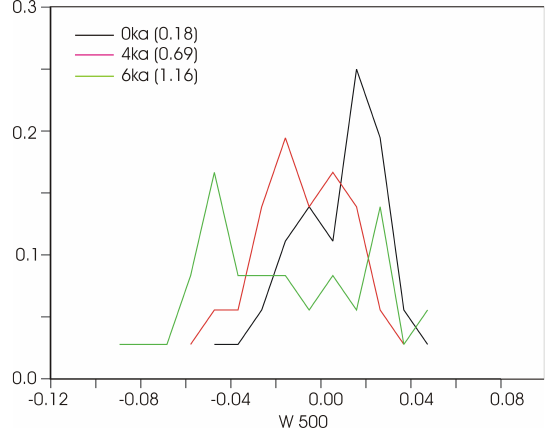
Fig. 6. Probability density function of 500hPa (w500, in hPas − 1 ) vertical velocity over Lake Yoa region (17.5–22.5 ◦ E, 17–22 ◦ N) for 6ka (green), 4ka (red) and ctrl (black). Positive values represent subsidence regions and negative values convective regions. Vertical velocity is used as a proxy for convection.